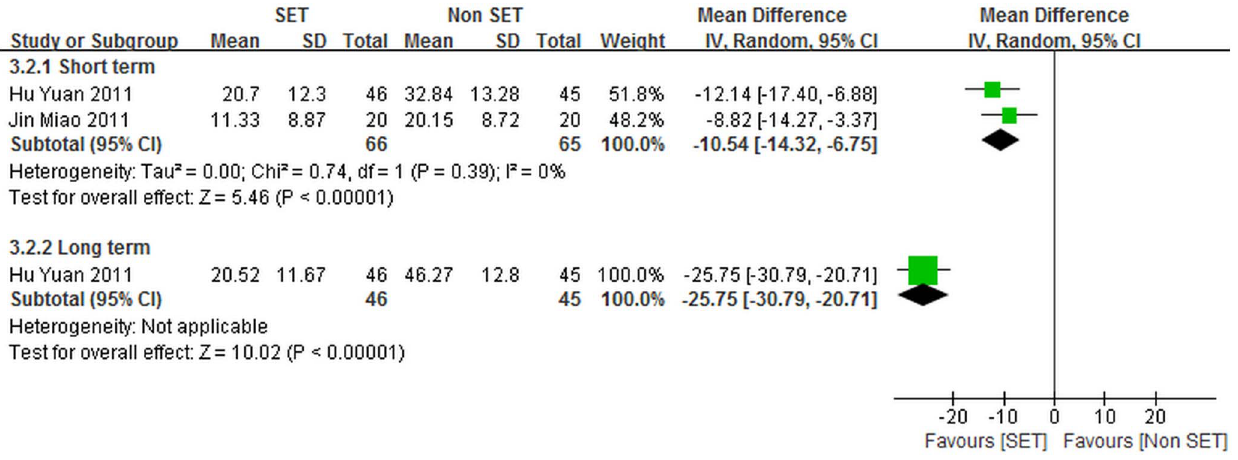
Figure 6. Back pain specific functional status for sling exercise versus thermomagnetic therapies.